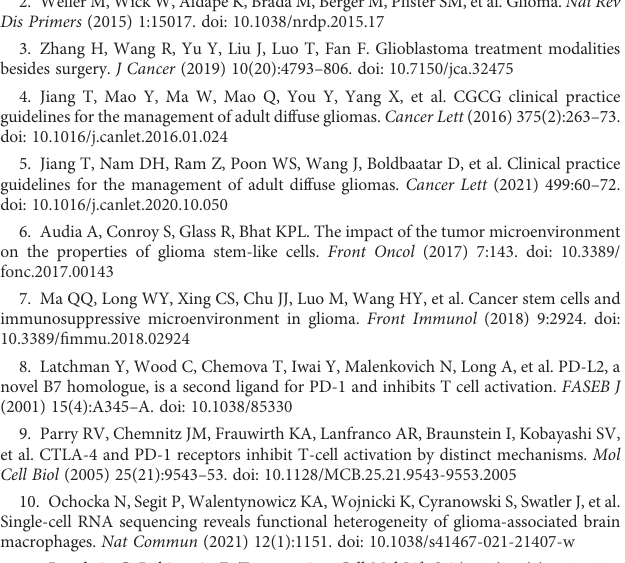
SUPPLEMENTARY FIGURE 3 (A-C) The expression pattern of TSPAN7 in the spatial transcriptome. SUPPLEMENTARY FIGURE 4 Survival analysis between TSPAN7 low- and high-expression in glioma with different IDH mutant status. (A-B) TCGA, TSPAN7 in IDH mutant and Wildtype (WT) glioma, (C-D) CGGA_325,TSPAN7inIDHmutantandWTglioma, (E-F) CGGA_693,TSPAN7in IDH mutant and WT glioma, (G-H) GSE16011, TSPAN7 in IDH mutant and WT glioma. SUPPLEMENTARY FIGURE 5 The relationships between TSPAN7 expression and immune in fi ltration of 22 immune cellsingliomaimmunemicroenvironment. (A,B) Relativeimmunecellin fi ltrationlevel of22immunecellsbetweenTSPAN7highexpressionandlowexpressionsubgroupin (A) TCGA and (B) CGGA datasets. *p s<.05, **p <.01, ***p <.001, ****p <.0001, ns: no statistics.